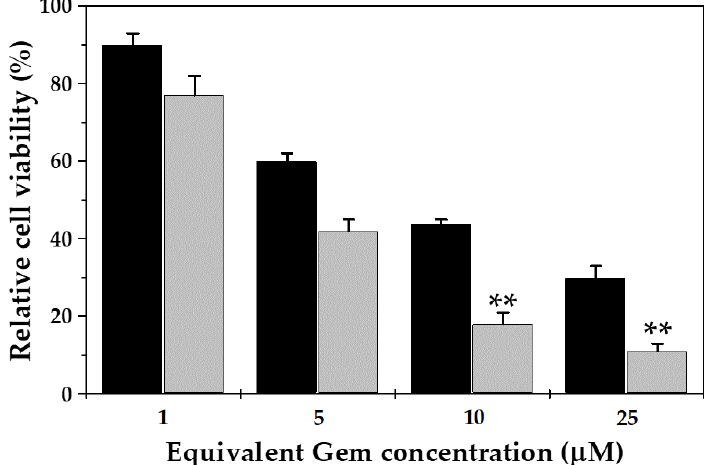
Figure 8. In vitro cytotoxicity of free Gem (black column) and Gem-loaded magnetic nanocomposites (of 2:4 Fe 3 O 4 :PCL weight ratio) (light grey column) in MCF-7 human breast cancer cells, after 72 h of exposure to a wide range of NP concentrations (up to 25 μM equivalent Gem concentration). Statistical analysis was done using Student’s t -test considering 95% confidence interval. The statistical test was significant, ** p < 0.05, compared with the free Gem-treated group.